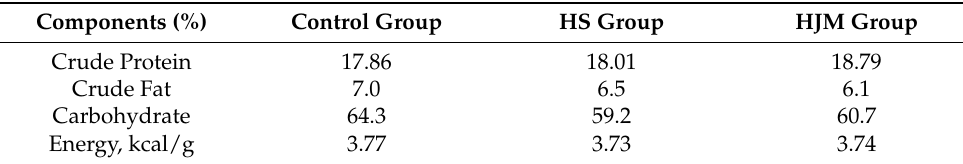
Figure 3. Mean weekly food consumption of male and female rats. Figure 4. Total body weight gains, total food consumption, and total food utilization for 10 weeks in male and female rats. A: control group; B: HS group; C: HJM group. ( I ): total body weight gain; ( II ): total food consumption; ( III ): total food utilization. Compared with the control group, * P < 0.05.